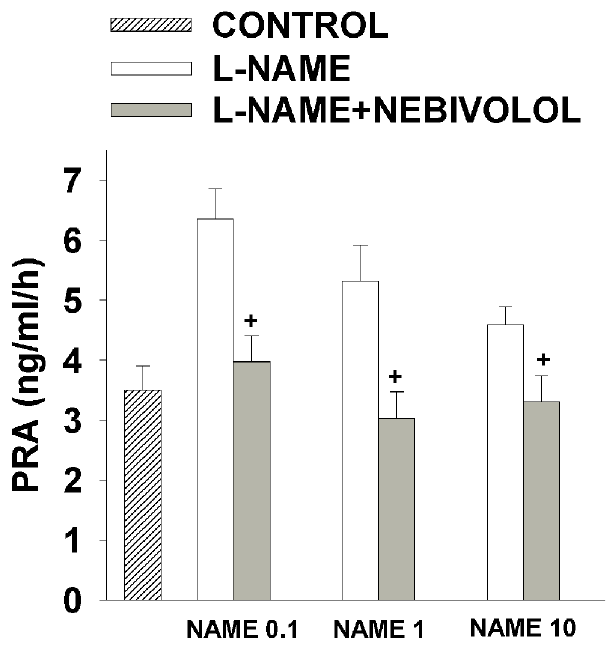
FIGURE 4 . Plasma renin activity (PRA) in the experimental groups after 2 weeks of treatment. +, p < 0.05 vs. L-NAME– treated